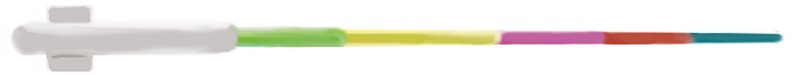
IAP CURAPROX probe.